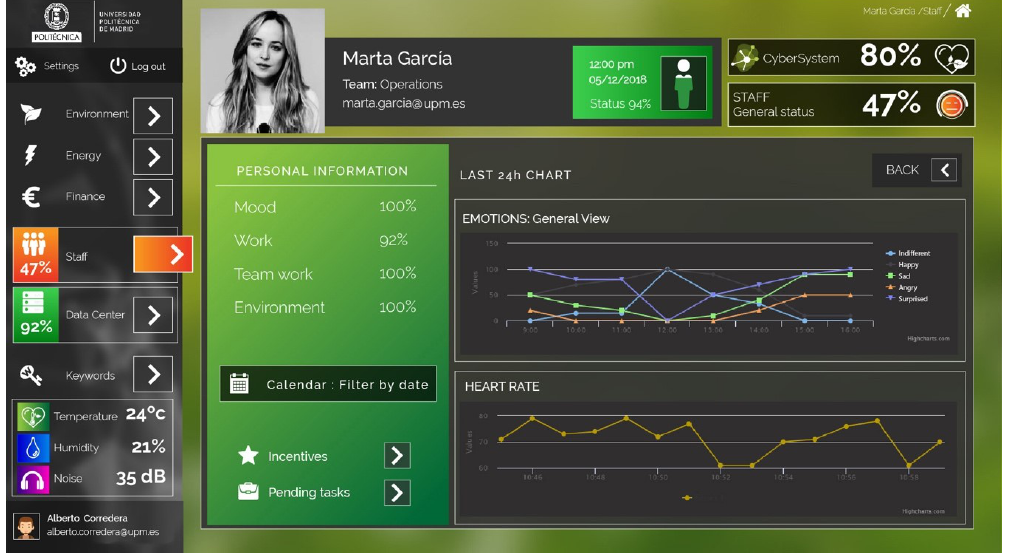
Figure 2. Employee record with historical data